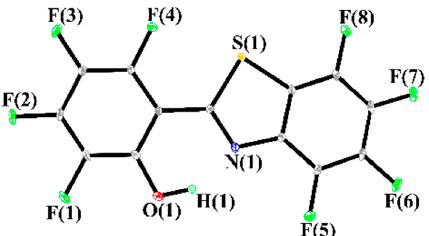
Figure 2. Molecular structure of independent molecules of H(SON F ) (thermal ellipsoids are drawn at 30% probability).